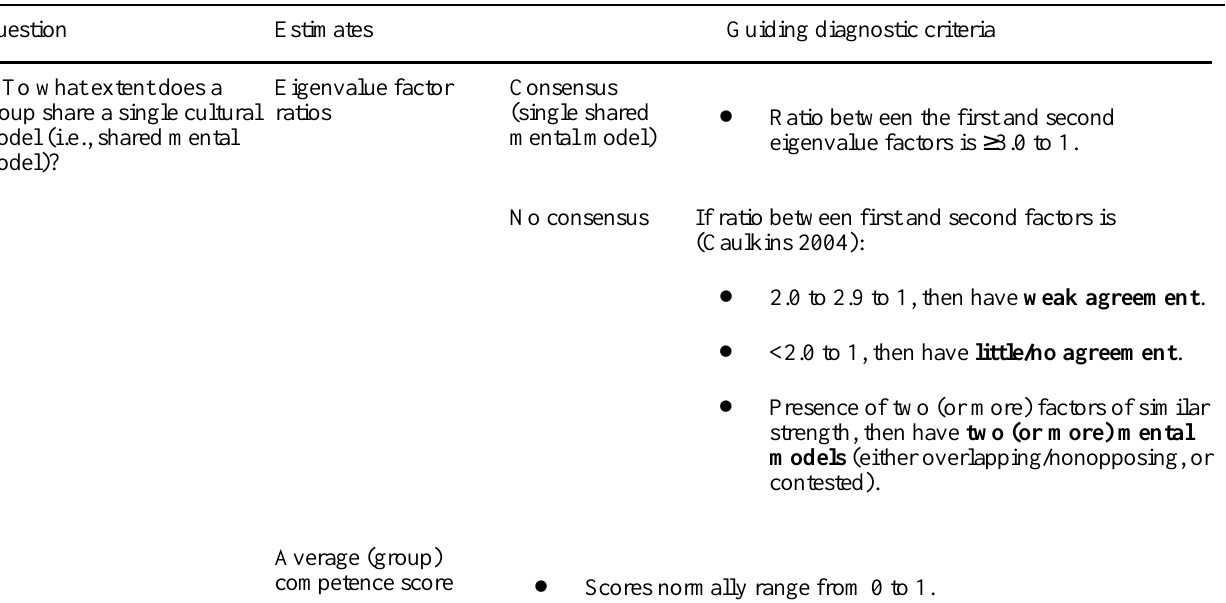
Table 1 . Key questions addressed by consensus analysis, estimates produced by the consensus analysis module in Anthropac (Borgatti 1996a), and guiding diagnostic criteria used in our